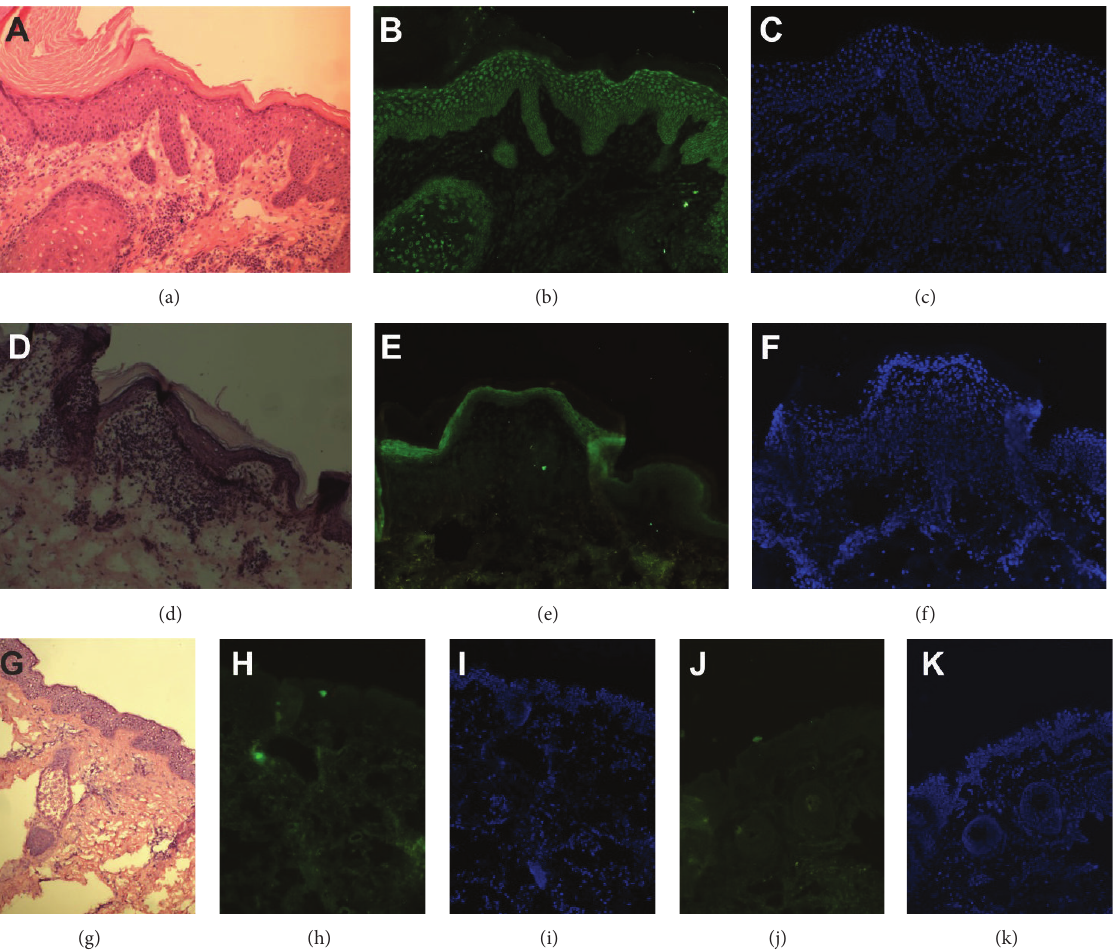
Figure 1: Expression of IL-31 was found in the entire epidermis of lichen planus lesions ((a)–(c): patient 1, (d)–(f): patient 2) in comparison to no expression in healthy skin ((g)–(i): volunteer 1, (j)-(k): volunteer 2) ((a), (d), and (g): hematoxylin/eosin staining of fresh-frozen section, (b), (e), (h), and (j): anti-IL-31 immunostaining, and (c), (f), (i), and (k): DAPI staining, original magnification ×